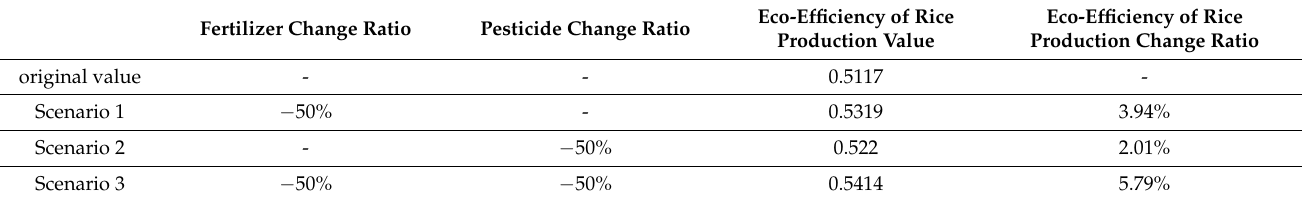
Table 9. Improvement potential of the eco-efficiency via rice production scenario